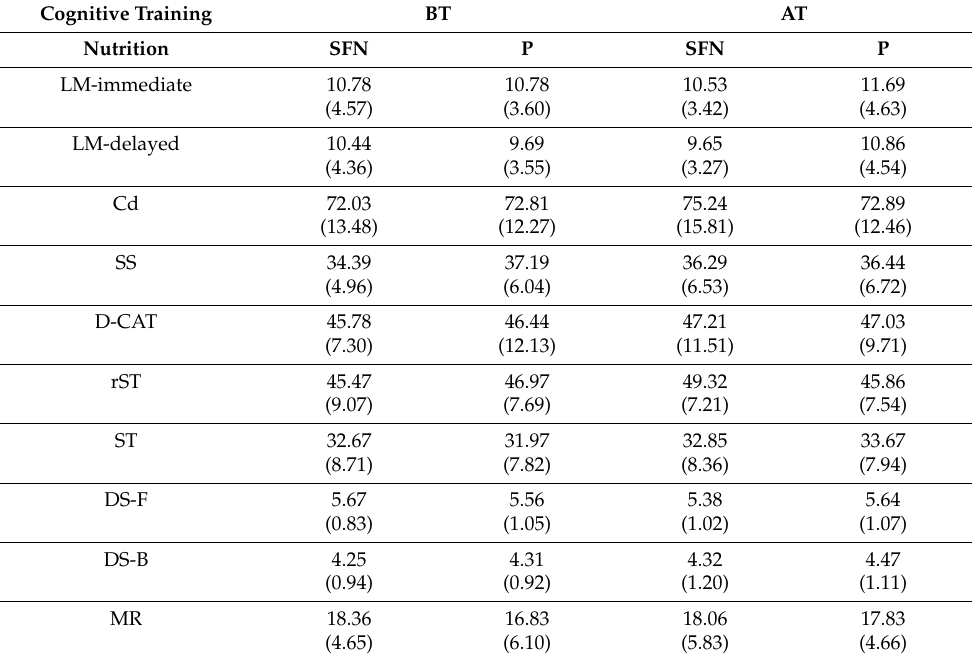
Table 2. Cognitive functions of the participant groups at baseline.